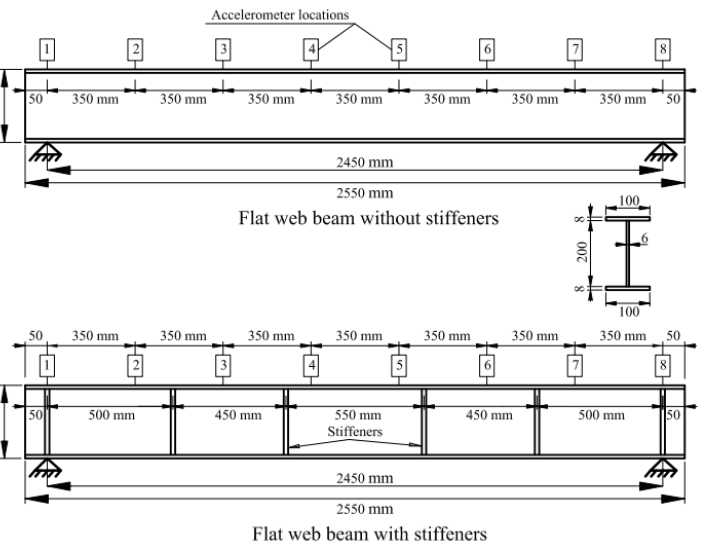
Figure 1. Flat web beams’ elevation, cross-section, and arrangement of stiffeners and accelerometers.